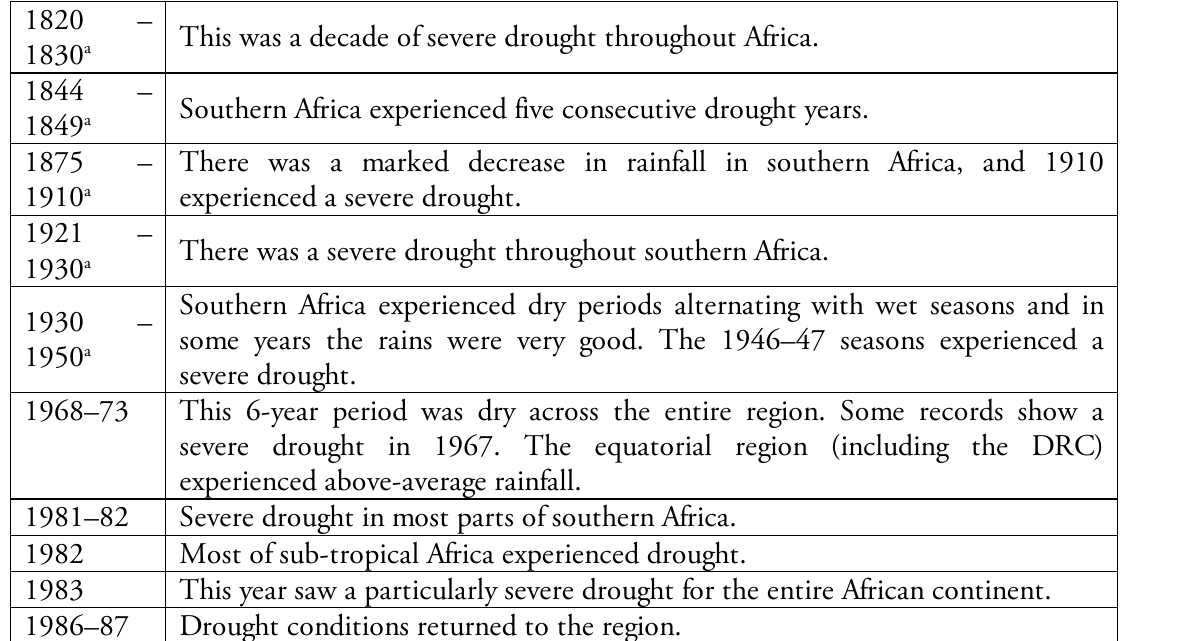
Table: 1 Chronology of droughts and floods in southern